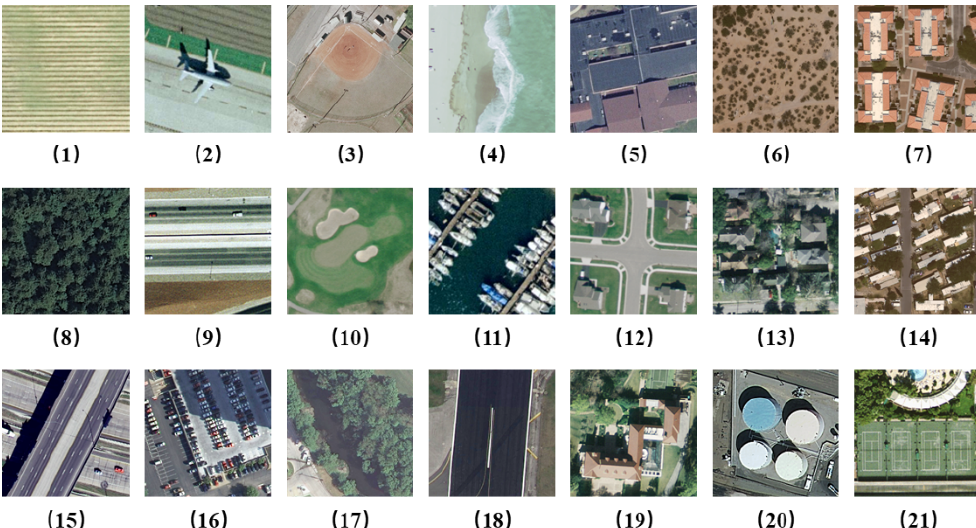
Figure 6. Example images of the UCM dataset: ( 1 ) agricultural, ( 2 ) airplane, ( 3 ) baseball diamond, ( 4 ) beach, ( 5 ) buildings, ( 6 ) chaparral, ( 7 ) dense residential, ( 8 ) forest, ( 9 ) freeway, ( 10 ) golf course, ( 11 ) harbor, ( 12 ) intersection, ( 13 ) medium residential, ( 14 ) mobile home park, ( 15 ) overpass, ( 16 ) park- ing lot, ( 17 ) river, ( 18 ) runway, ( 19 ) sparse residential, ( 20 ) storage tanks, ( 21 ) tennis court.